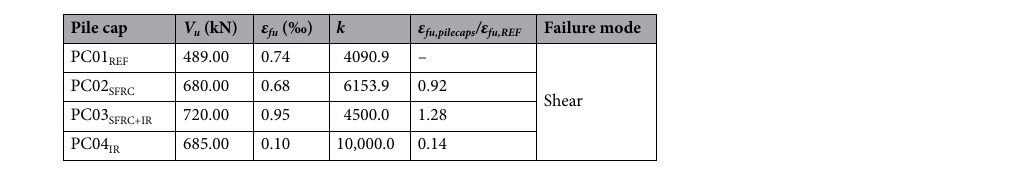
Table 8. Parameters that define the V − ε f ratio.